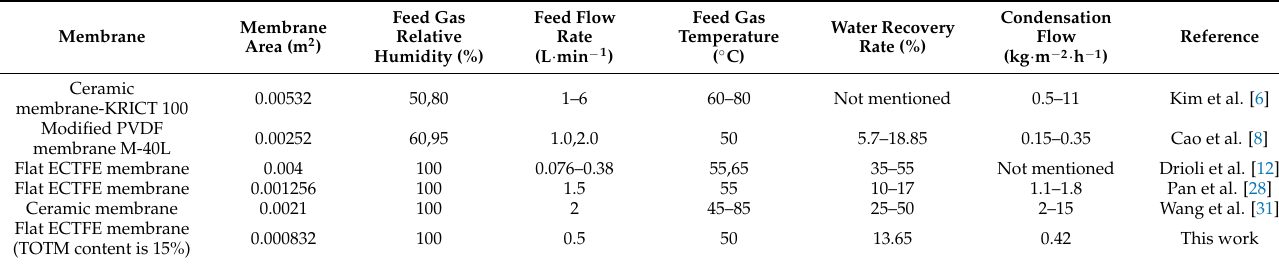
Table3. Literature data of membrane condenser. Table 3. Literature data of membrane